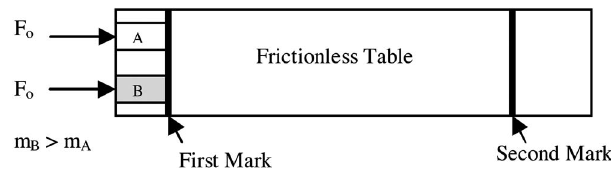
FIG. 1. Diagram (cid:1) top view (cid:2) used in all recitations for the pretest.